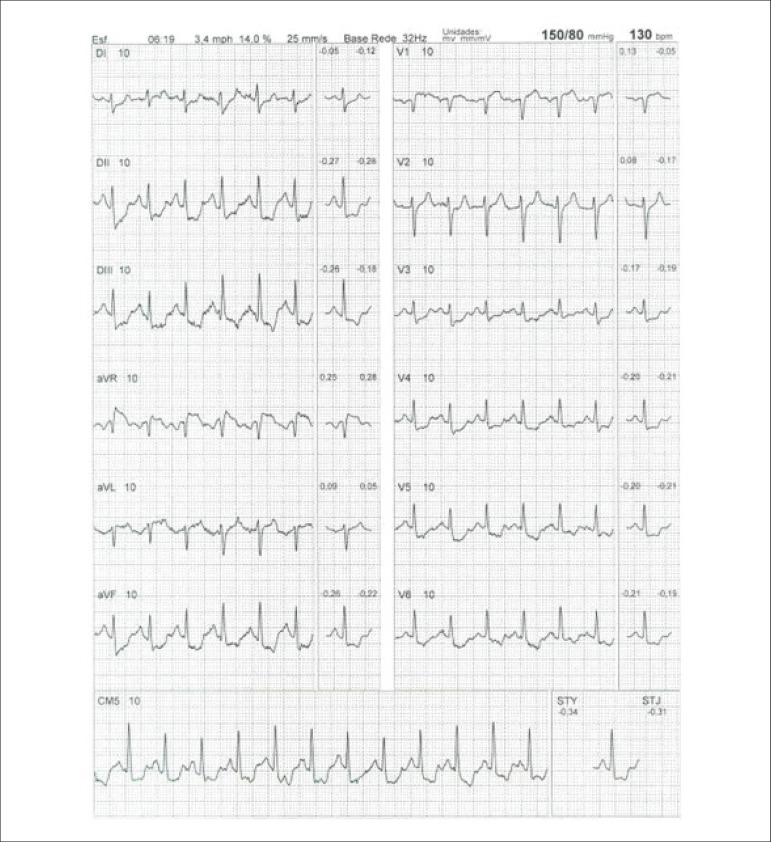
Case 5 - Electrocardiogram tracing demonstrating ischemic electrocardiographic alterations in multiple leads, with submaximal heart rate levels. Detailed explanation in the text.